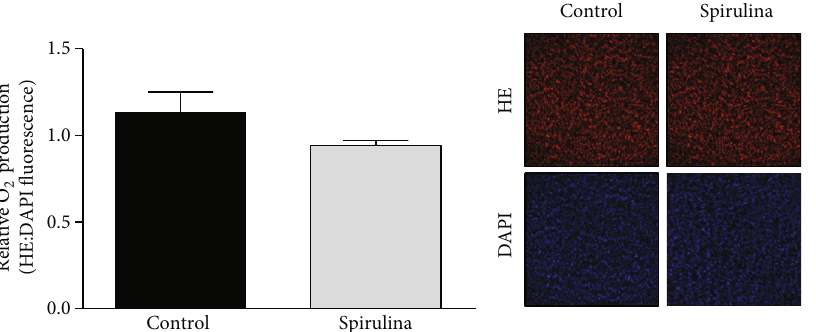
Figure 5: E ff ect of the aqueous Spirulina extract incubation on the production of superoxide anion in aortic segments from SHR. Representative confocal images showing in situ detection of superoxide anion in red and DAPI-nuclei staining in blue. Quantitative analysis of fl uorescence is also shown. Results ( means ± SEM ) are expressed as the ratio between the fl uorescence emitted by hydroethidine (HE) and that emitted by DAPI. Number of animals: 4.